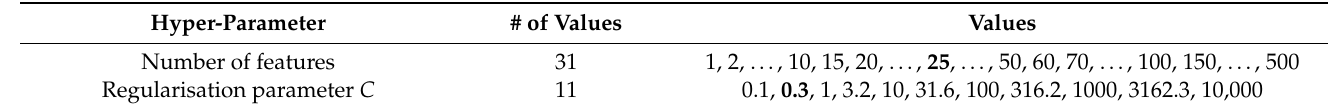
Table 3. Parameters and values used for the grid search approach to improve the ML model. “Number of features” means the selected features that are used for classification. Bold numbers indicate the selected hyper-parameters for Section